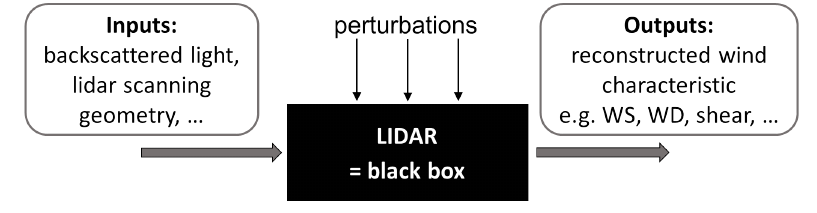
Figure 2. Black box lidar